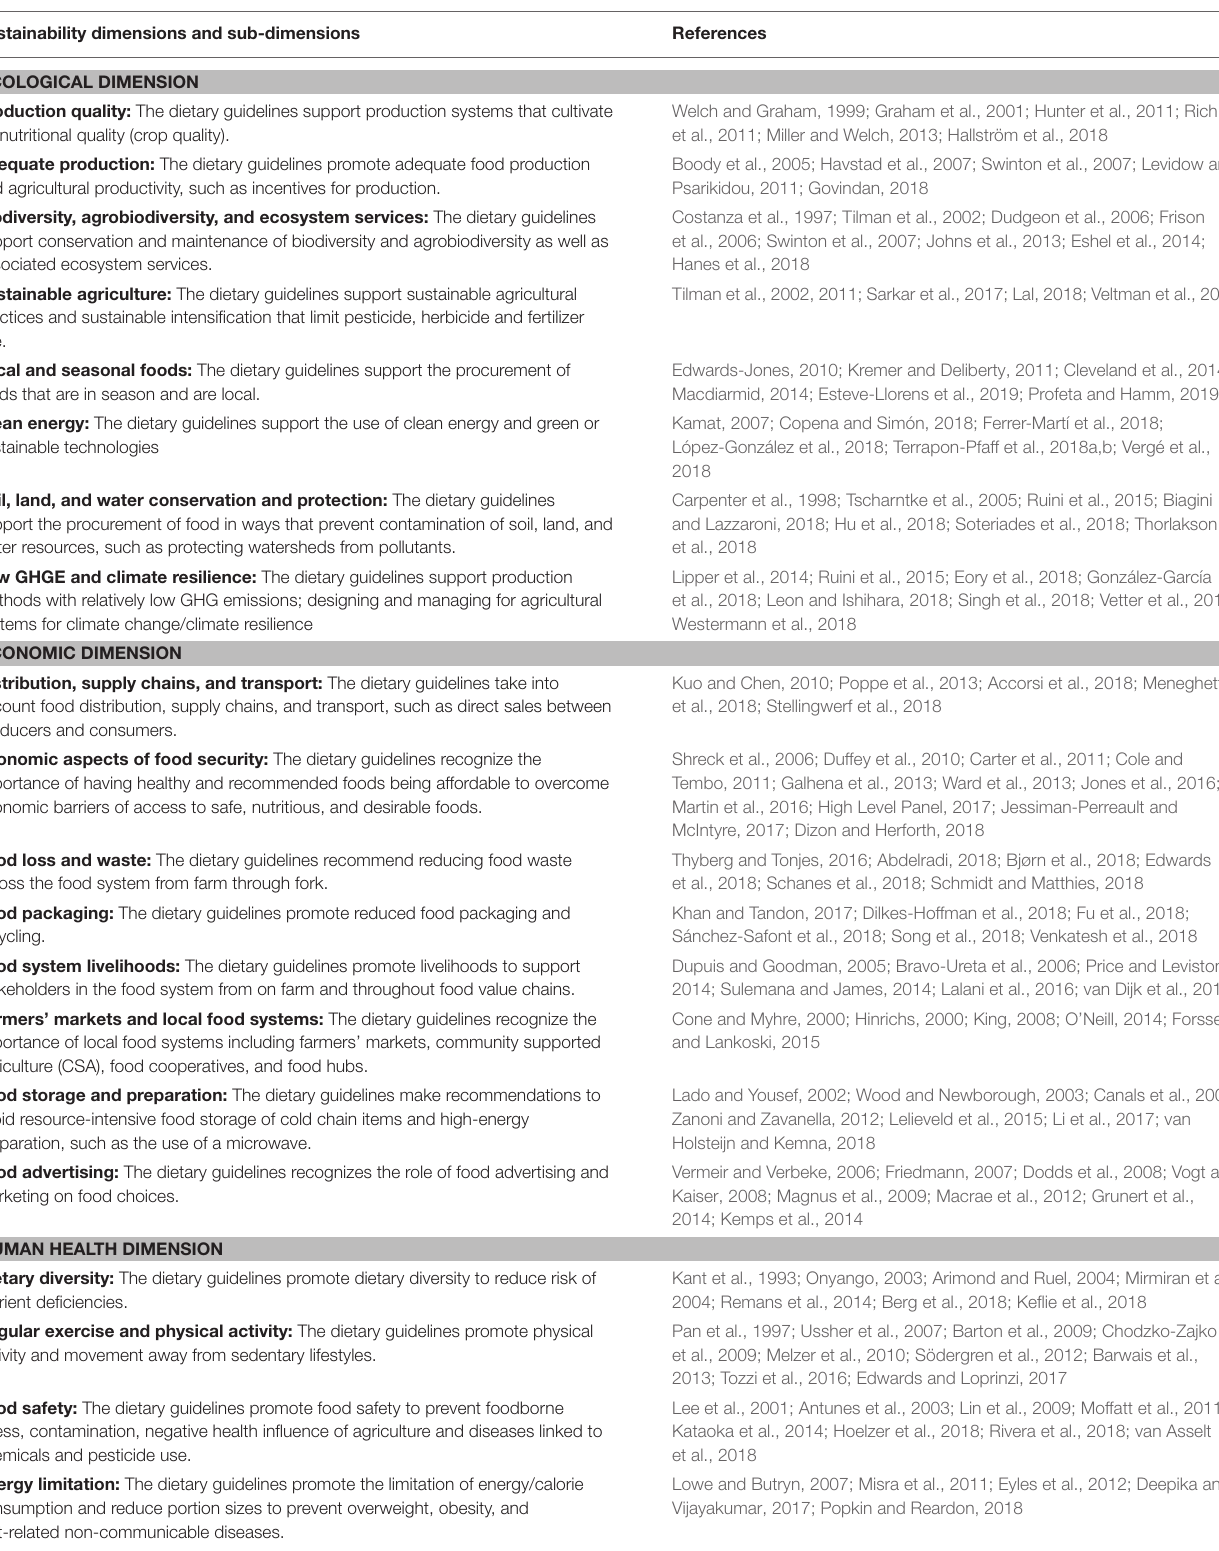
TABLE 1 | Sustainability framework tool for evaluating national dietary